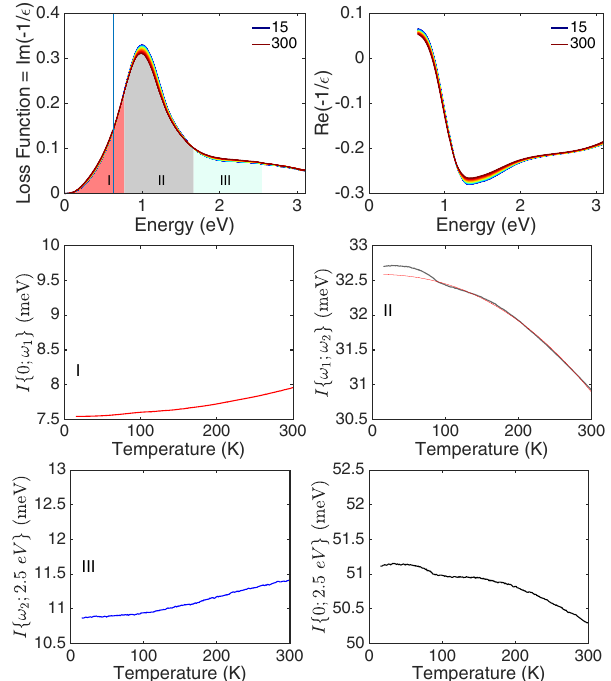
FIG. 8. Loss function and loss-function integrals of sample Bi2212-60-UD. The value of the fitted exponent α is 2.0 (right middle panel). Panel details are further specified in the main text.